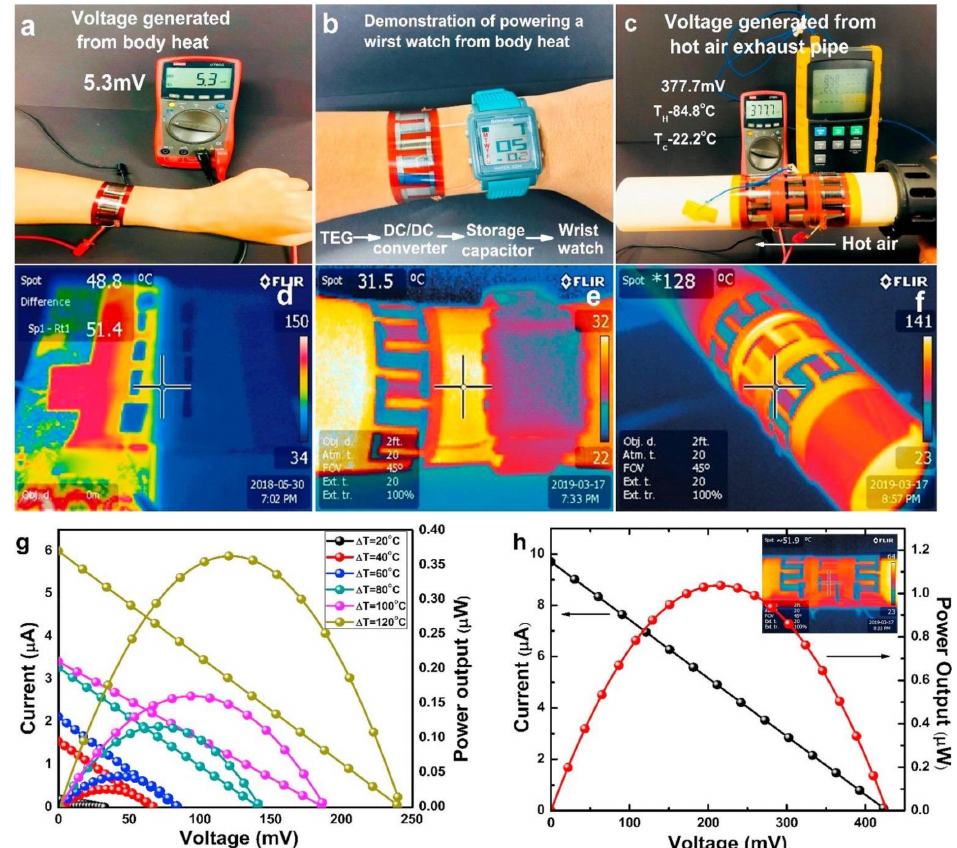
Figure 9. Voltage produced by developed TEG applied on the human body ( a ) for recharging of a watch ( b ); voltage generated when applied on hot air exhaust pipe ( c ); infrared pictures of TEG under different heat sources ( d–f ); load characteristics of single TEG under different temperature gradients (@T cold = 22.2 ◦ C) ( g ); load characteristics of TEGs connected in series exposed to a 120 ◦ C temperature gradient ( h )